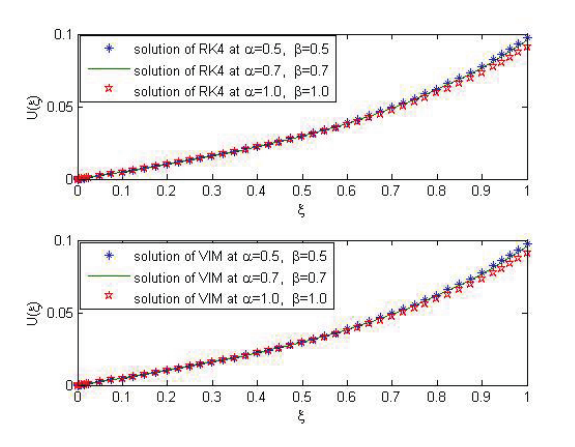
Fig. 3: The behavior of the approximate solution using RK4 (Top) and VIM (Bottom) with different values of K and L